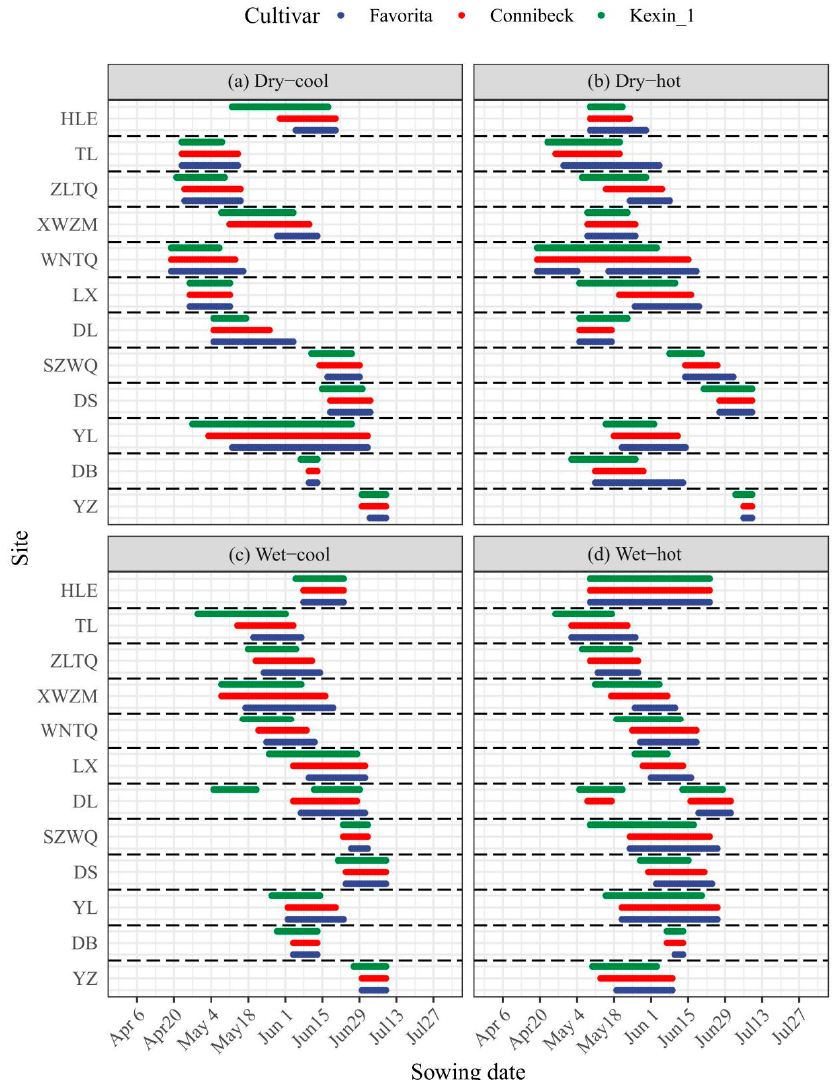
Figure 5. OPP of three mature cultivars in different water-temperature year types across the APE of North China. Different horizontal bands represent different meteorological stations of the APE in North China. ( a – d ) refers to four different year types. Different colors represent different cultivars: blue line for cultivar Favorita, red line for cultivar Connibeck and green line for cultivar Kexin_1.